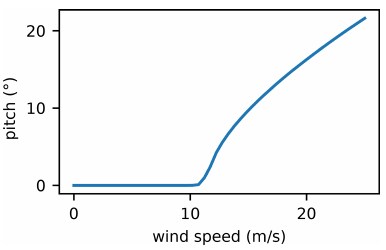
Figure 3. Blade pitch angle versus wind speed for the NREL 5MW reference